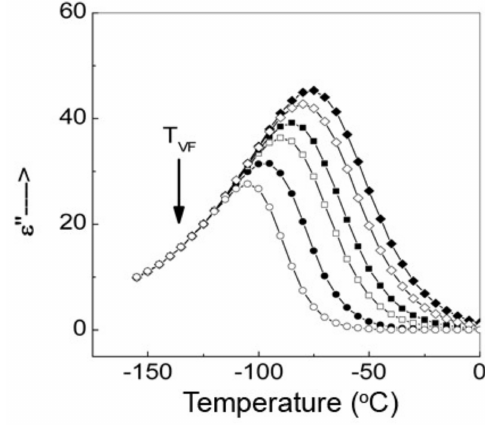
Figure 8. The phenomenological fitting to the observed imaginary part of the dielectric data ( ε